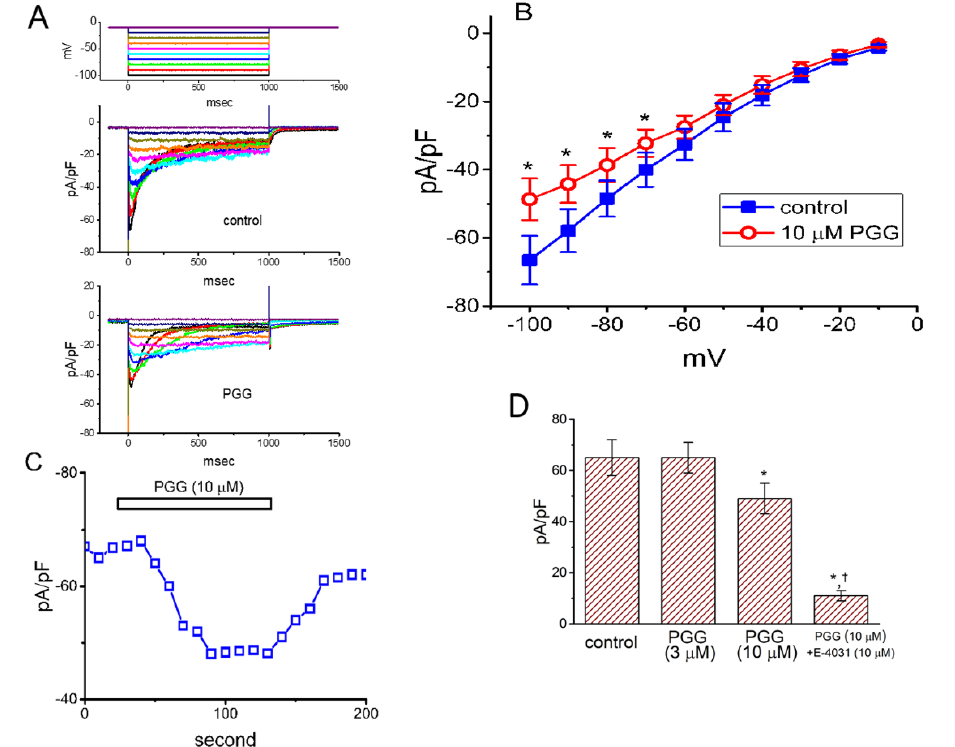
Figure 3. Inhibitory effect of PGG on erg -mediated K + current ( I K(erg) ) identified in GH 3 cells. In these whole-cell recordings, we bathed cells in a high-K + , Ca 2+ -free solution, and the pipette was filled up with K + -containing solution. ( A ) Representative I K(erg) density obtained in the control (i.e., in the absence of PGG; upper) or during the exposure to 10 μM PGG (lower). The uppermost part denotes the voltage protocols applied. ( B ) Mean I K(erg) density versus voltage relationships obtained in the absence ( ■ ) or presence ( ○ ) of 10 μM PGG (mean ± SEM; n = 8 for each point). Current density was measured at the start of each voltage step. The statistical analyses were made by ANOVA-2 for repeated measures, p (factor 1) < 0.05, p (factor 2) < 0.05, p (interaction) < 0.05, followed by post-hoc Fisher’s least-significant difference test, p < 0.05. * indicates a significant difference from controls measured at the same level of the hyperpolarizing step ( p < 0.05). ( C ) Time course of I K(erg) density obtained during cell exposure to 10 μM PGG. Each point ( □ ) was measured at the start of a 1-sec hyperpolarizing pulse from −10 to −100 mV, and the horizontal bar shown above indicates the application of PGG (10 μM). ( D ) Summary bar graph demonstrating the effects of PGG (3 and 10 μM) and 10 μM PGG plus 10 μM E-4031 on I K(erg) density (mean ± SEM; n = 7). Current density was measured at the beginning of the hyperpolarizing step from −10 to −100 mV. The statistical analyses were done by ANOVA-1, p < 0.05, followed by a post-hoc Fisher’s least-significant difference test, p < 0.05. * indicates a significant difference from control ( p < 0.05), and † indicates a significant difference from the PGG (10 μM)-alone group ( p < 0.05).